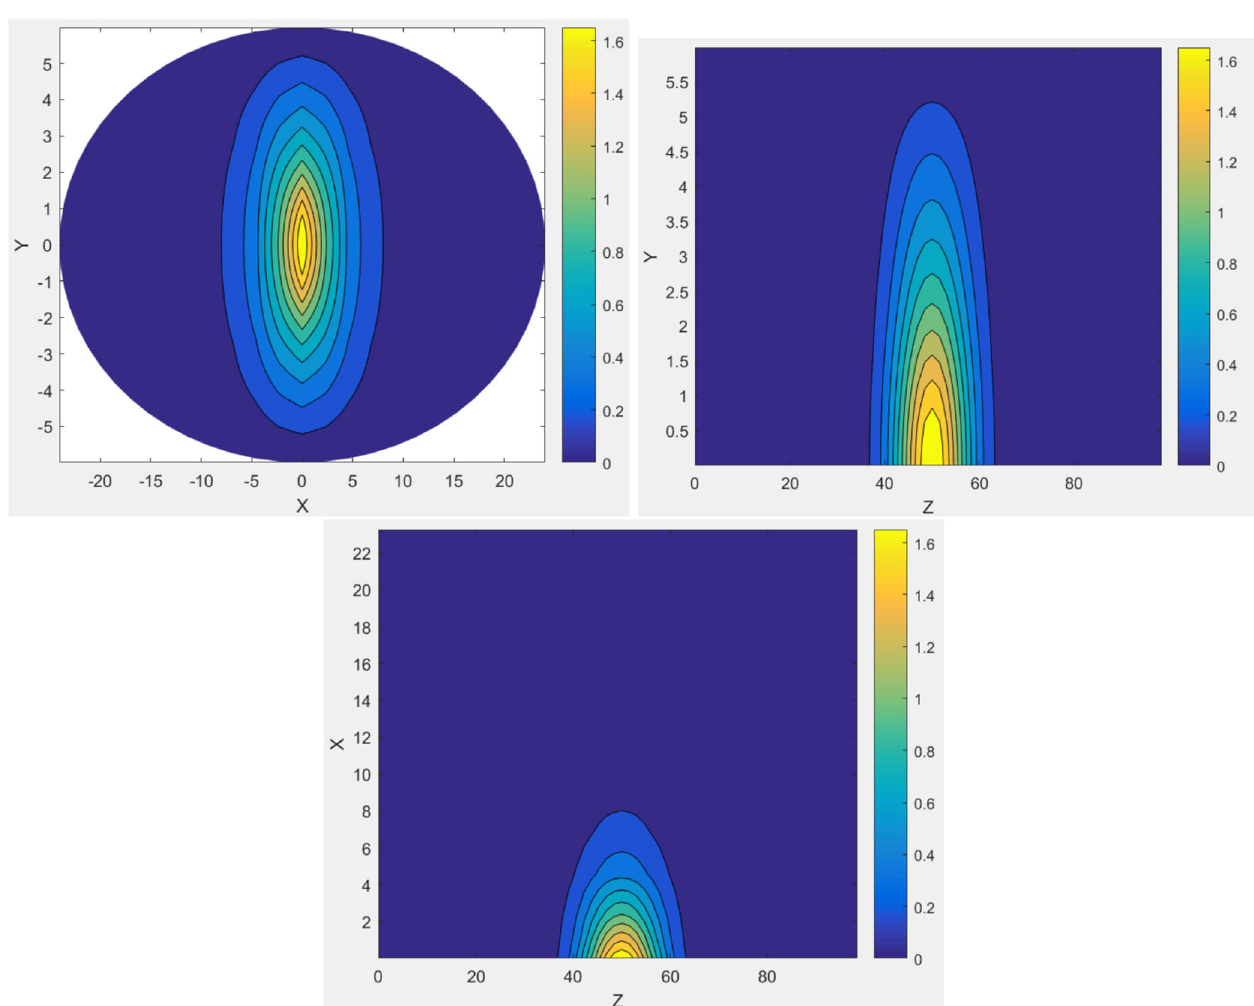
FIG. 6. The normalized electric potentials in the middle X − Y plane (upper left), the middle Z − Y plane (upper right), and the middle Z − X plane (bottom) from the pseudospectral method using a 3D bunched Gaussian density distribution with longitudinal open boundary condition and transverse elliptical conducting